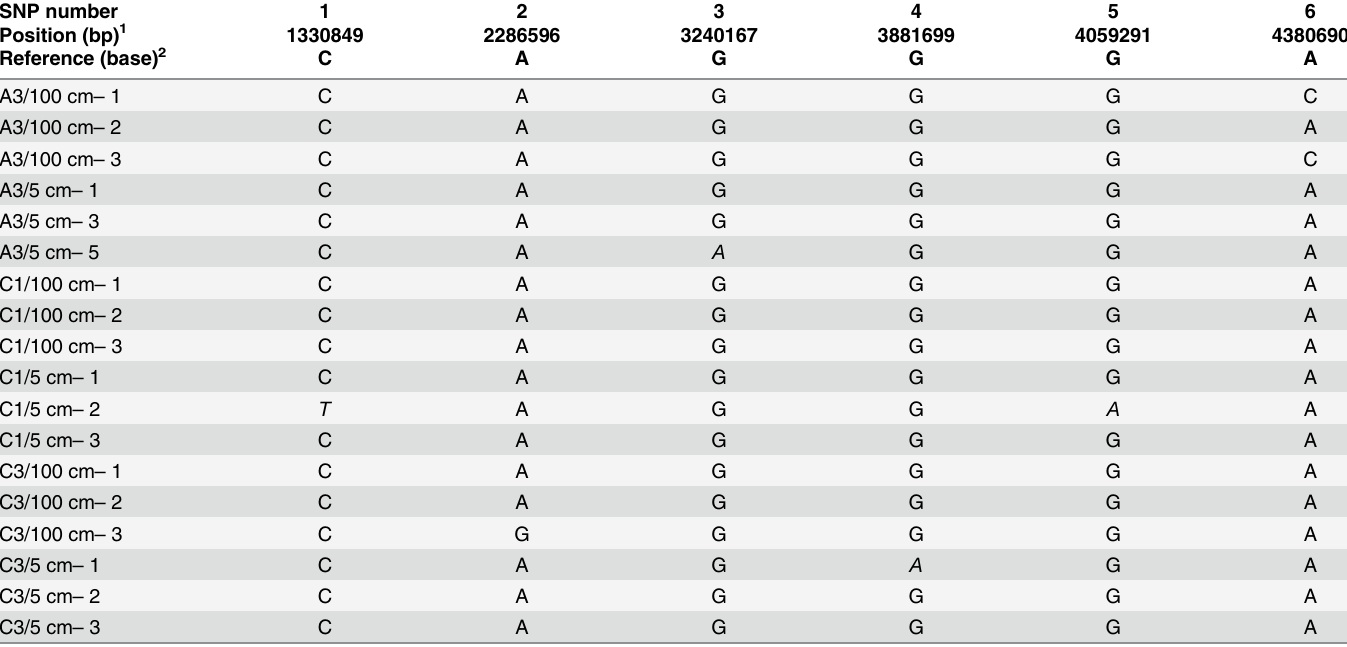
Table 6. SNPs in Pollino isolates detected by whole genome sequencing. SNPs are numbered according to their position in the reference genome 1 ( B . anthracis Ames Ancestor; GenBank accession: AE017334). The bases at the respective positions are shown for Pollino isolates and the reference 2 . SNPs are highlighted in